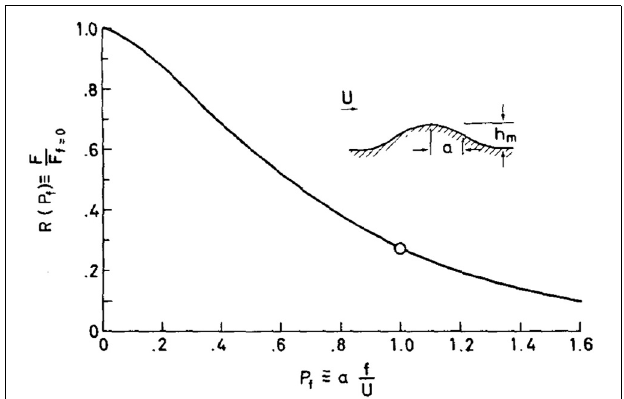
FIGURE 12 | Drag normalized by (30) as a function of fa / U for flow over a bell-shaped ridge. Reproduced from Figure 1 of Smith [125]. © American Meteorological Society. Used with